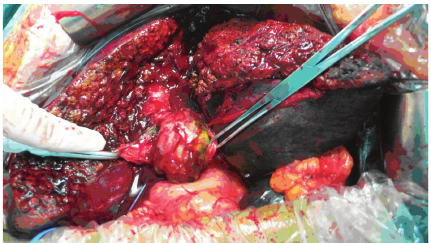
Figure 4: Tumor thrombus in the right posterior sectoral ducts, the common hepatic duct, and the common bile duct.